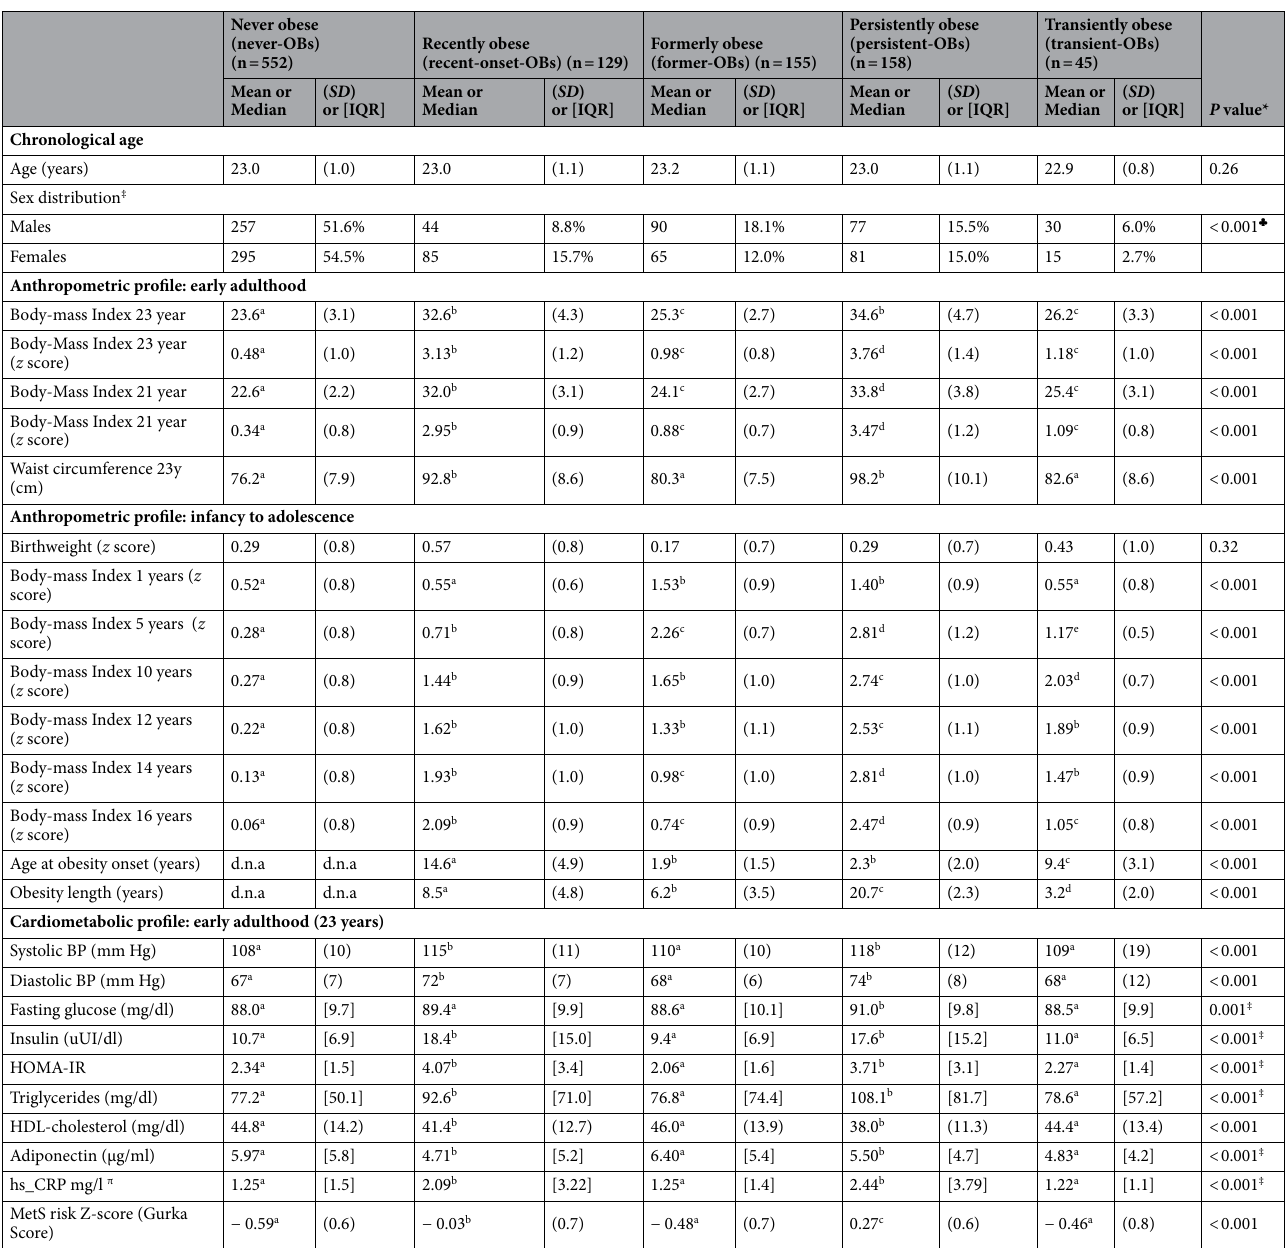
Table 1. Anthropometric and cardiometabolic profile in 23-years-old participants in the SLS, by obesity status (n = 1039). *Analysis of Variance with Bonferroni correction, except as indicated. Sex distribution expressed as number of participants and percentage. ‡ Kruskal–Wallis Test by ranks. ♣ Pearson’s Chi2 test for independence. Means or medians in a row without a common superscript letter differ, as analyzed by one-way ANOVA or Kruskal–Wallis test. π Participants with hs_CRP > 9 (mg/l) were excluded from the analysis (n = 171). Anthropometric data and sex distribution were also reported in a previous work from our group. See Burrows et al . 42